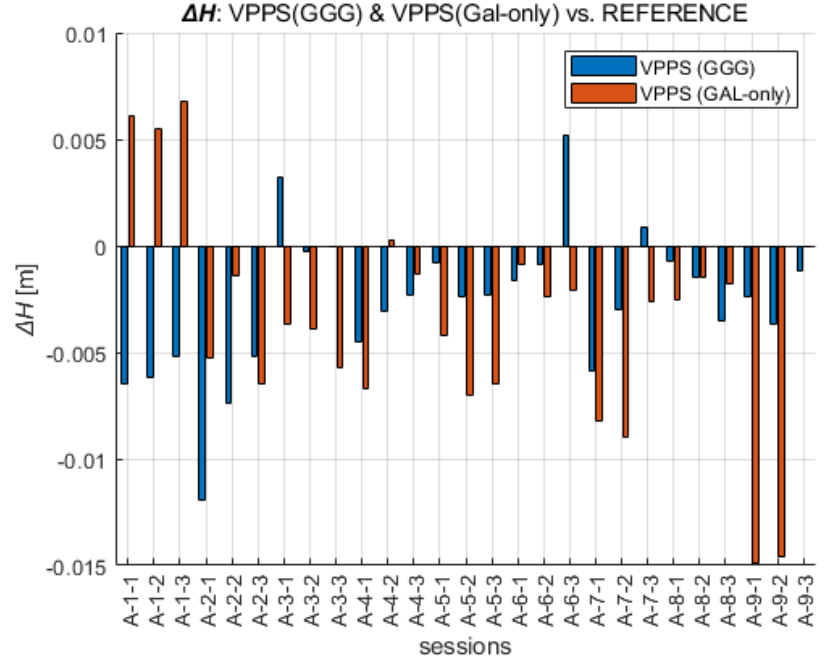
Figure 11. Height obtained with VPPS using GGG (cyan) and GAL-only (green) observations given as difference to the REFERENCE.